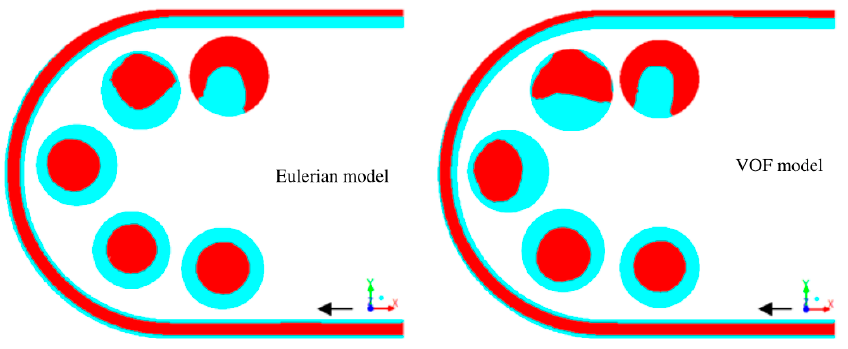
Figure 20. Two-phase distribution [34]. (Dark color for oil and light color for water.) Jiang et al., simulated the CAF flow through a ∏ -shaped bend. The viscosity of the